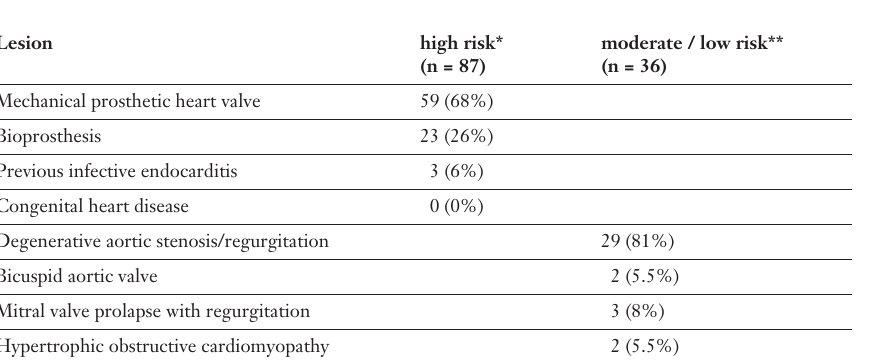
Cardiac lesions of study